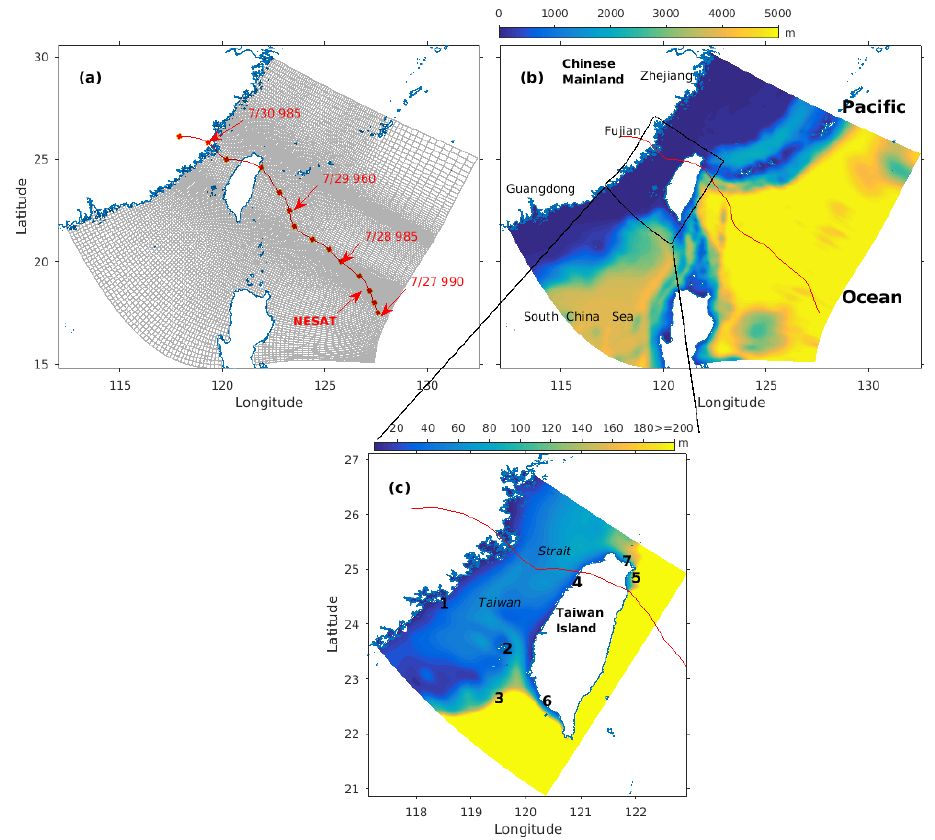
Figure 2. The distribution of model grids and bathymetry for ROMS and SWAN. ( a ) Model grid distribution showing track of Typhoon Nesat over six hour intervals (red squares) on 27–30 July, 2017, ( b ) regional bathymetry, and ( c ) enlarged image of bathymetry for the Taiwan Strait with numbers 1–7 denoting sites of in situ observational stations. The red curve in each subplot is the track of Nesat.